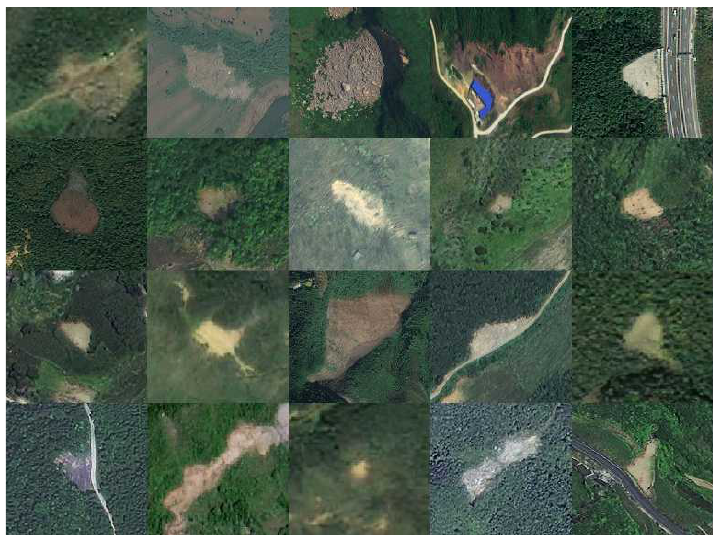
Figure 4. Examples of landslide samples in the test set, all from Bijie, Guizhou, China.